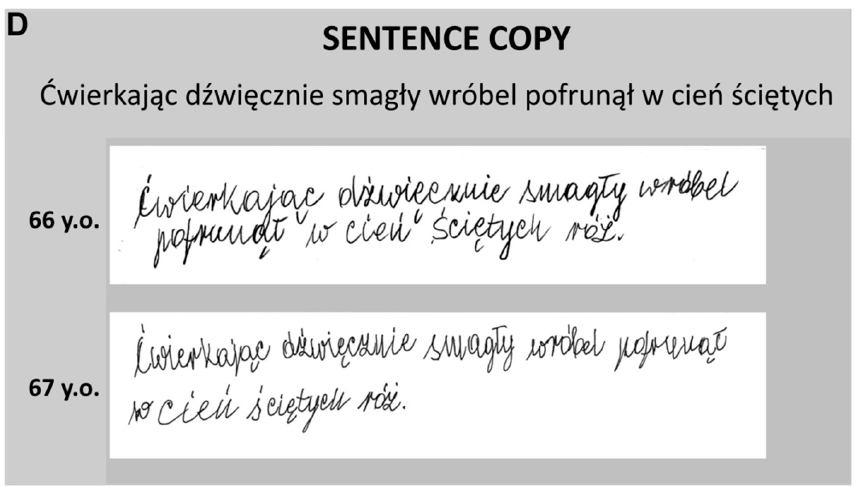
Figure 1. Neuroimaging and neuropsychology of the patient. ( A ). MRI at the age of 67 y.o.—bilateral, moderate frontal lobe atrophy; ( B ) SPECT- bilateral frontal and left parietal hypoperfusion; ( C ) cube copying task performed at 3 neuropsychological assessments. Even at the last assessment, when the patient drew with her left hand, the attempt to depict three-dimensionality is evident; ( D ) preserved sentence copying. Despite marked right upper limb rigidity, the patient was initially able to write.